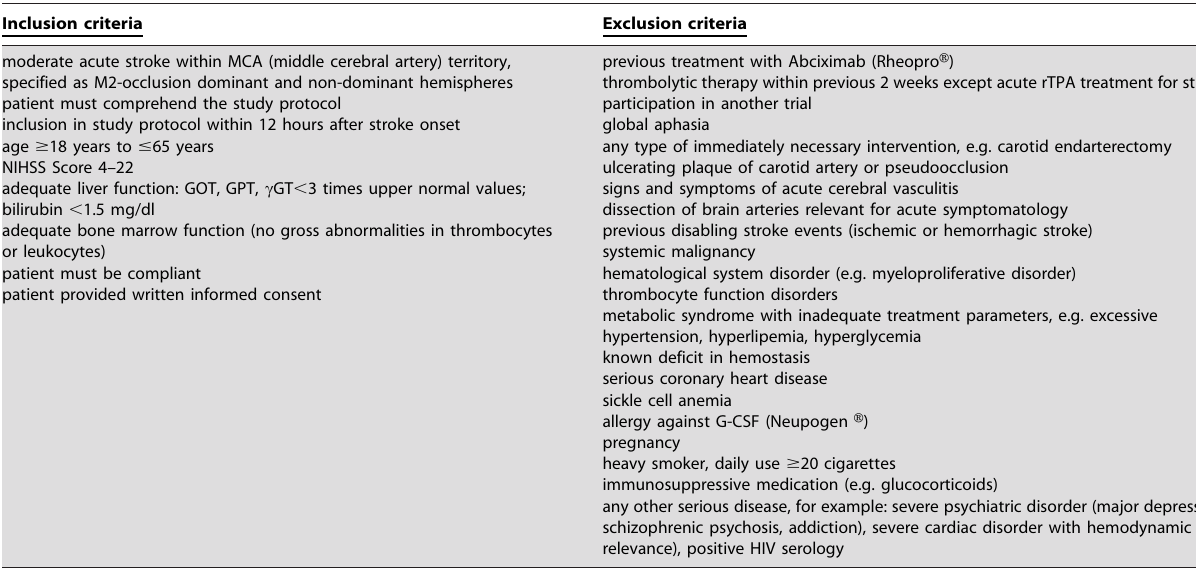
Table 1. Inclusion and exclusion